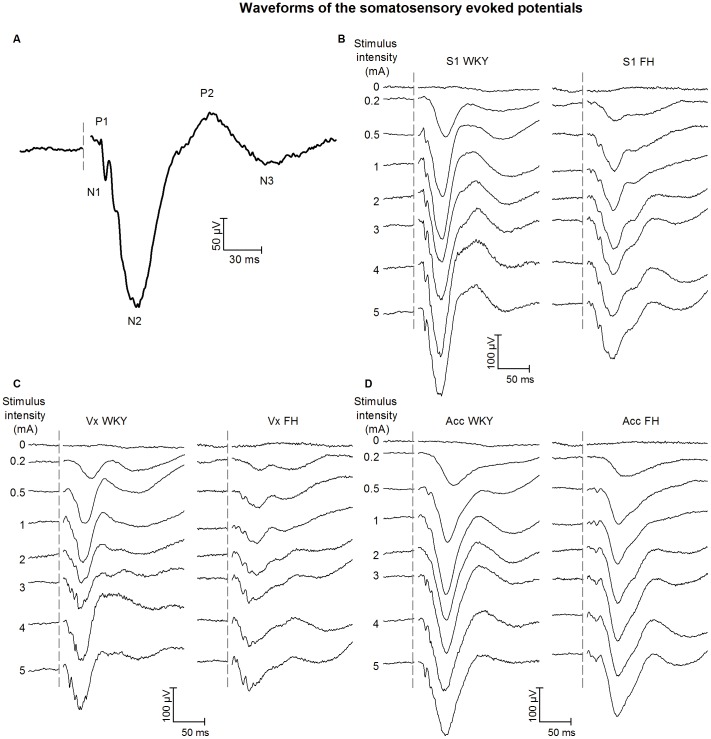
Waveforms of the somatosensory evoked potentials (SEPs) in different rat strains.(A) The S1-SEP waveform and its peak definitions of the WKY at a stimulation intensity of 3 mA. SEP waveforms of the S1 (B, WKY n = 9 and FH n = 12), Vx (C, WKY n = 10 and FH n = 12) and Acc (D, WKY n = 10 and FH n = 12) are shown for both the WKY and FH at different stimulation intensities. The stimulus frequency was 0.5 Hz. SEP waveforms resulted from averaging 32 responses per animal at each stimulus intensity. The dotted line in the curve interruption denotes the stimulus onset. FH =  Fawn Hooded, WKY =  Wistar Kyoto.